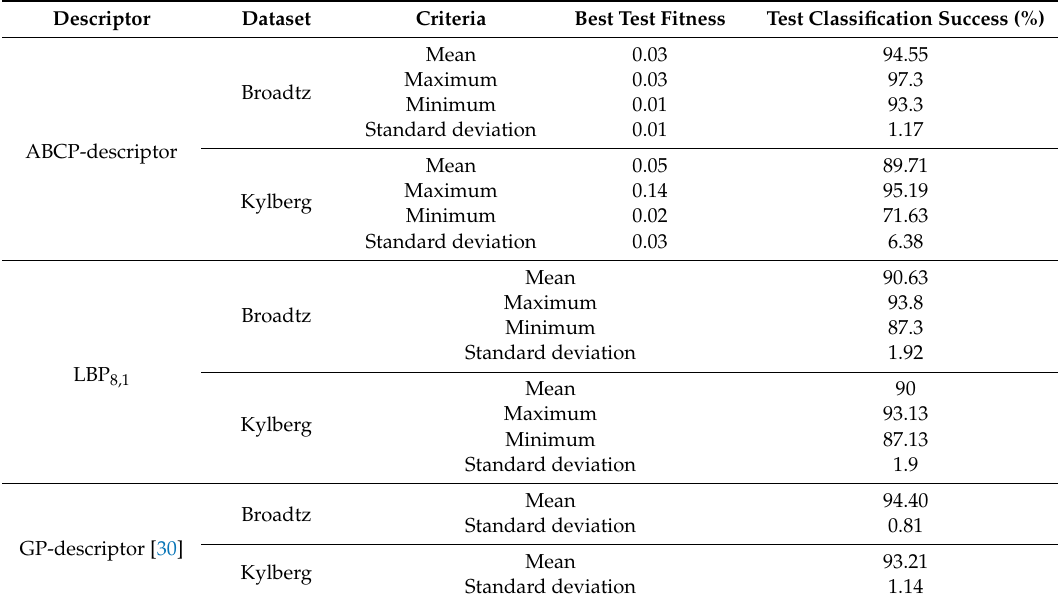
Table 3. Simulation results of descriptor.